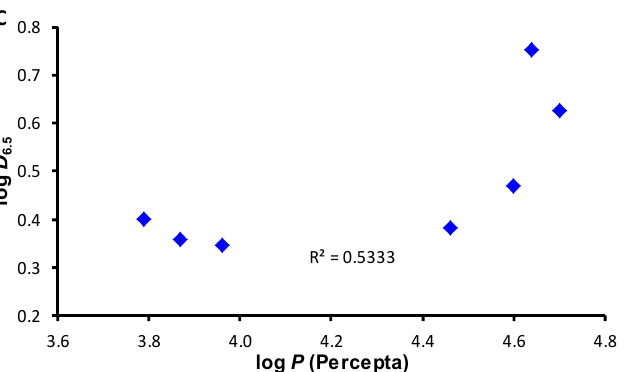
Figure 1. Comparison of predicted log P (ACD/Percepta) values with experimentally found log k ( A ), log D 7.4 ( B ), and log D 6.5 ( C ) values of ring-substituted (2 E )- N -aryl-3-[2-(trifluoromethyl)- phenyl]prop-2-enamides 1 – 7 .